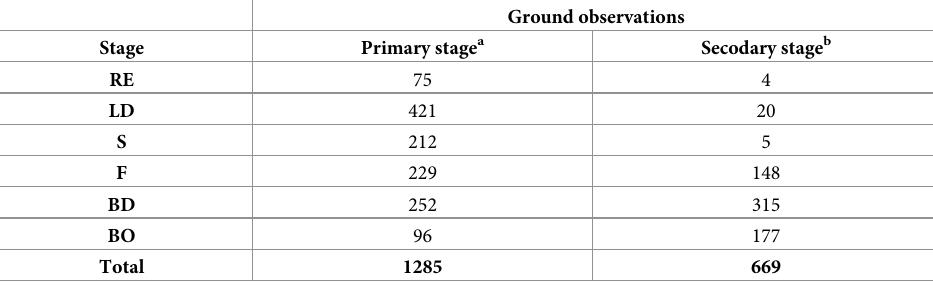
Table 2. Distribution of phenological